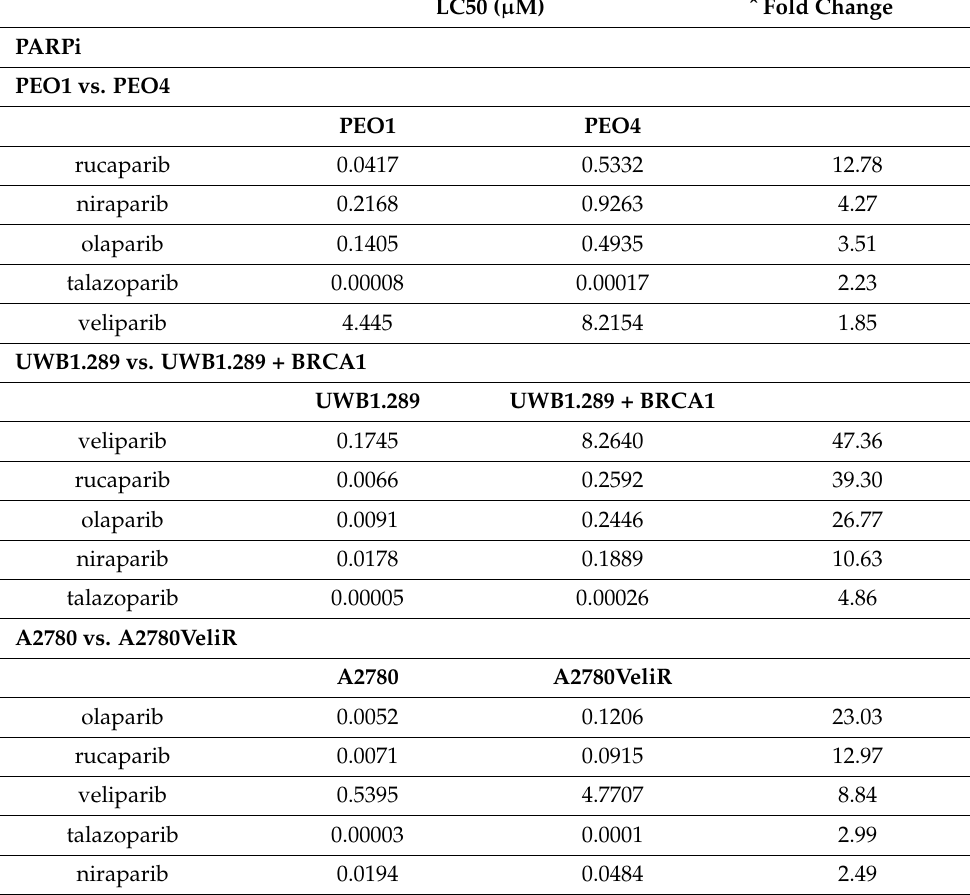
Table 2. LC50 comparisons (cell survival; clonogenic assay) for PARP is in BRCA1/2 –WT paired HGSOC cell lines and a parental–veliparib resistant endometrioid ovarian cancer cell